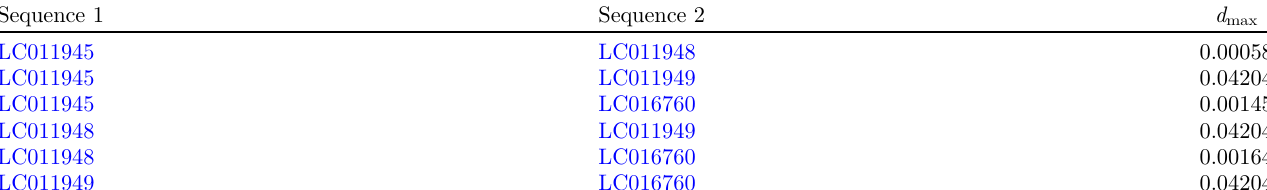
Table 3. d max values (see De fi nition 2.1-ii.). Columns 1 and 2 list the combinations of two sequences, from Table 2. Column 3 shows the value of d max for the sequences to its left.